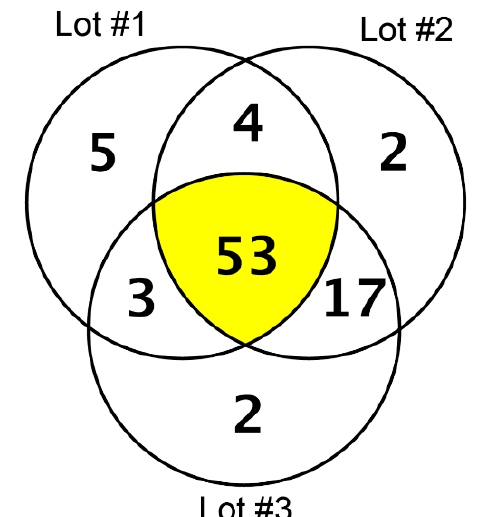
Figure 2. Proteins identified in three lots of the collagen matrix (Mucograft) by high-resolution shotgun proteomic analysis.